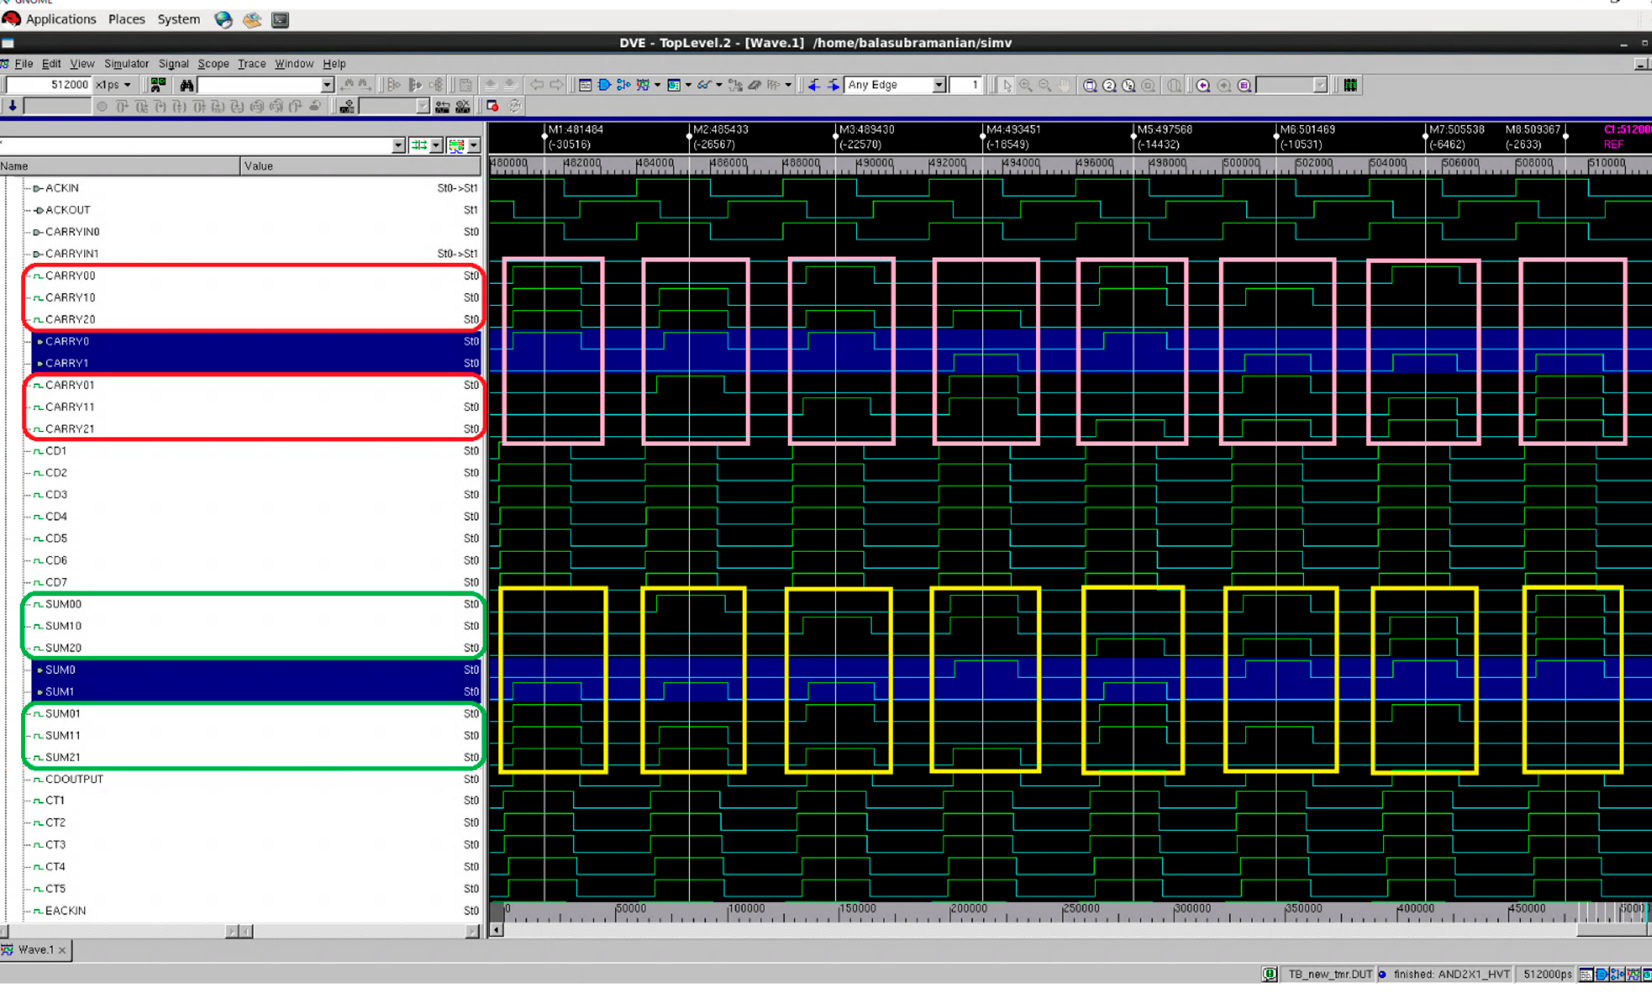
Figure 5. Screenshot of a portion of simulation waveforms of the TMR implementation incorporating the proposed majority voter (NEO_MV) corresponding to RTZH. Binary 1 represents data in the case of RTZH. Majority voted sum output (SUM1,SUM0) is captured within the yellow rectangles and majority voted carry output (CARRY1,CARRY0) is captured within the rose rectangles.